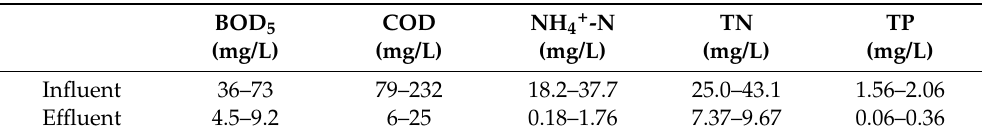
Table 1. The influent and effluent organic matter, nitrogen, and phosphorus concentrations of